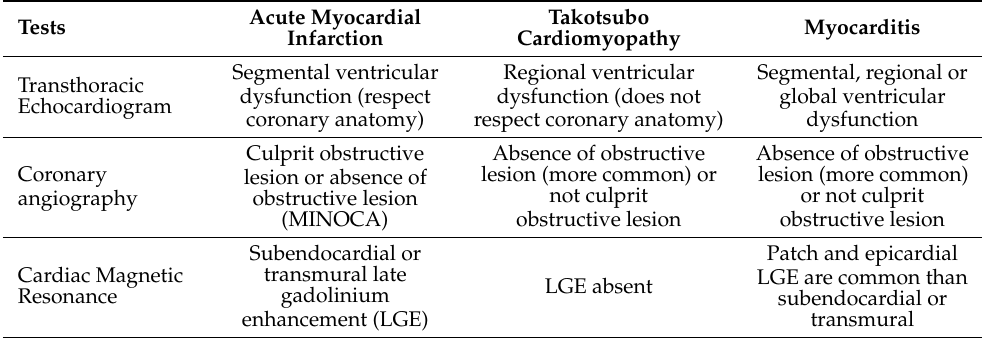
Table 4. Differential diagnosis of Takotsubo and tests